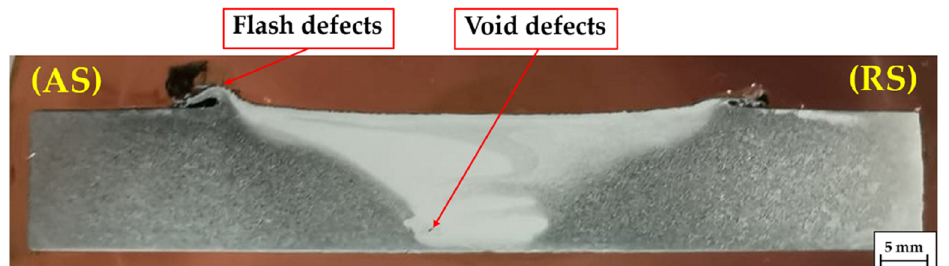
Figure 16. Macrostructural characteristics of FSW process of alloy SSM 5083 at the optimal conditions for tensile strength (a rotational speed of 1200 rpm, a welding speed of 10 mm/min, and with a threaded cylindrical tool pin profile).